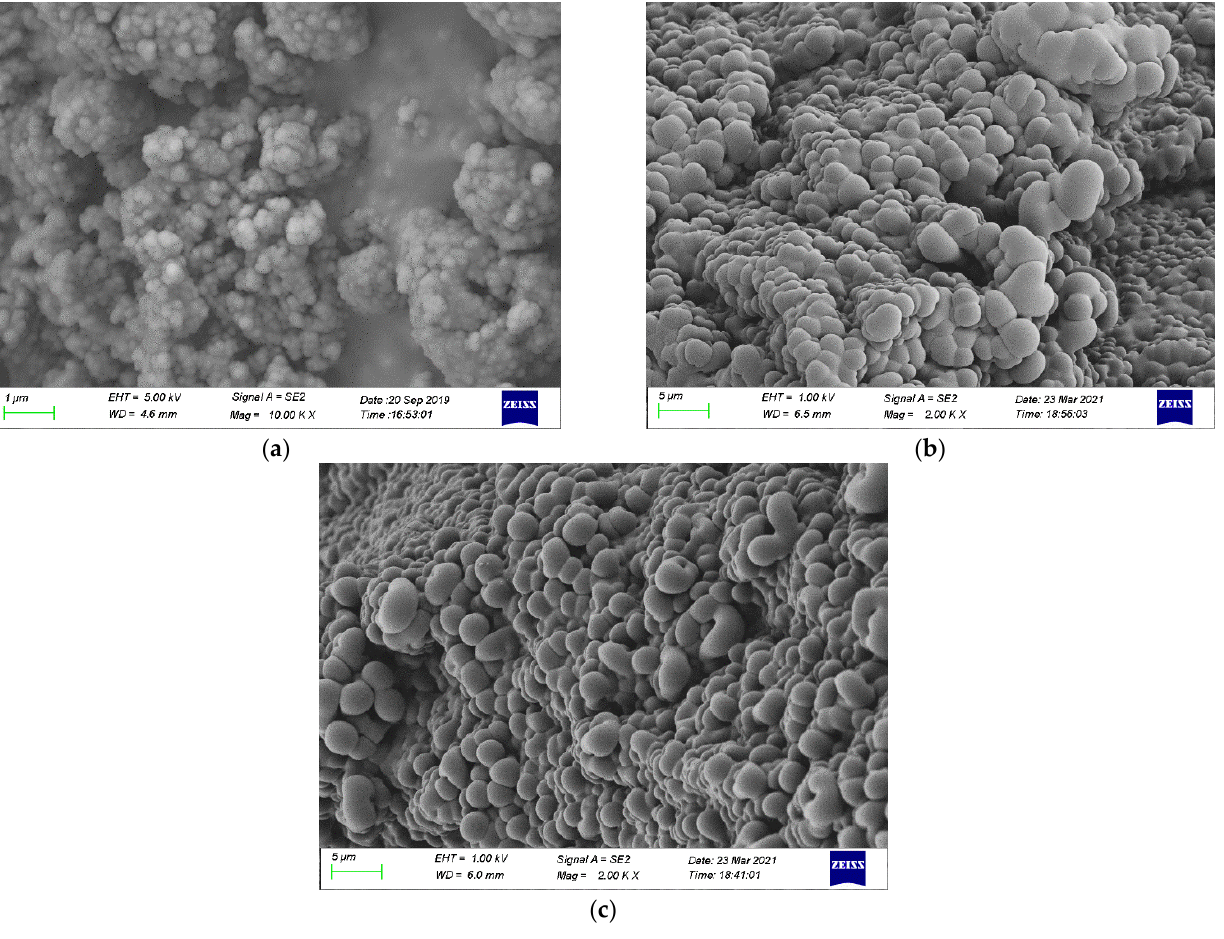
Figure 5. SEM images of paraffin (70%)/MS SS-PCMs with different particle size of MS:( a ) paraffin (70%)/MS1 SS-PCM; ( b ) paraffin (70%)/MS2 SS-PCM; ( c ) paraffin (70%)/MS3 SS-PCMs.